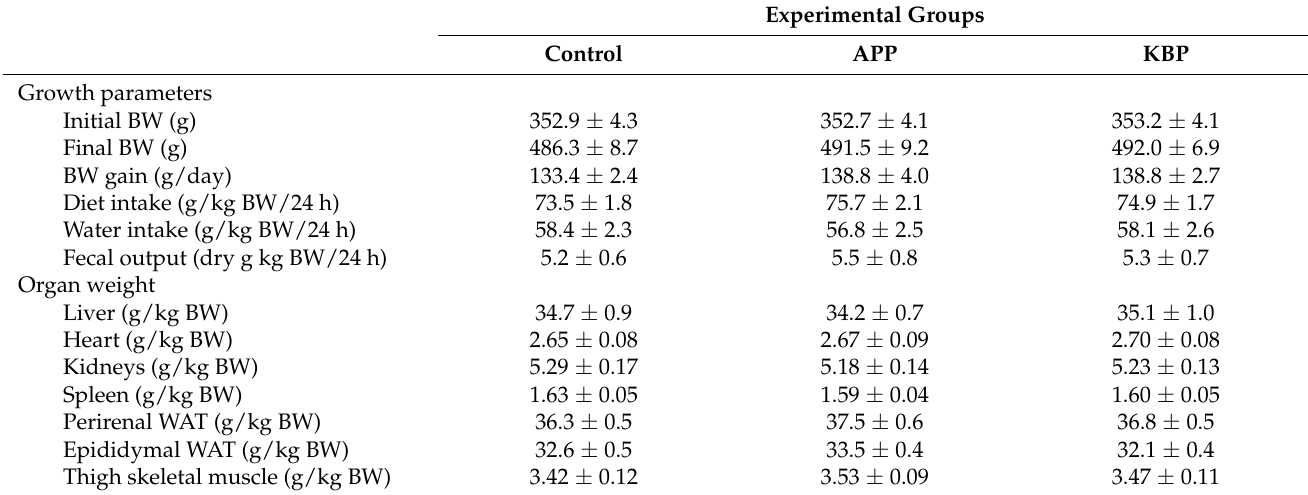
Table 3. Effect of dietary casein, APP, and KBP on growth parameters and organ weights in rats.